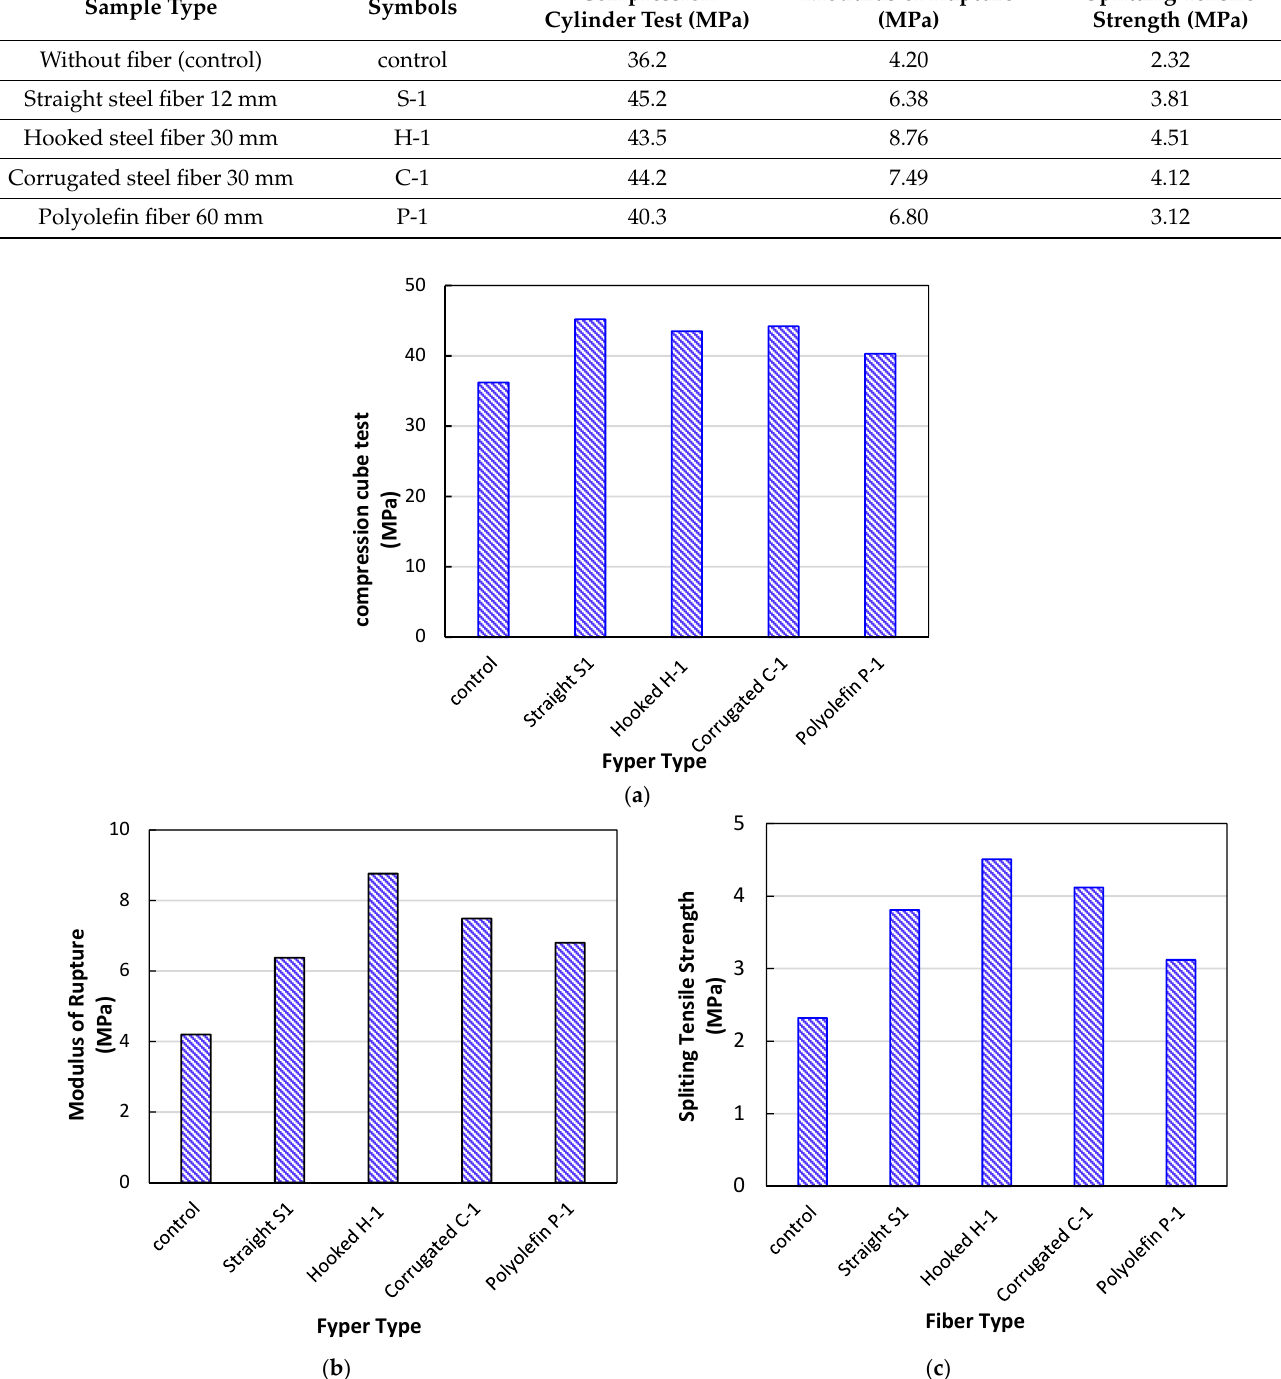
Table 6. Mechanical properties tested results of mixes.